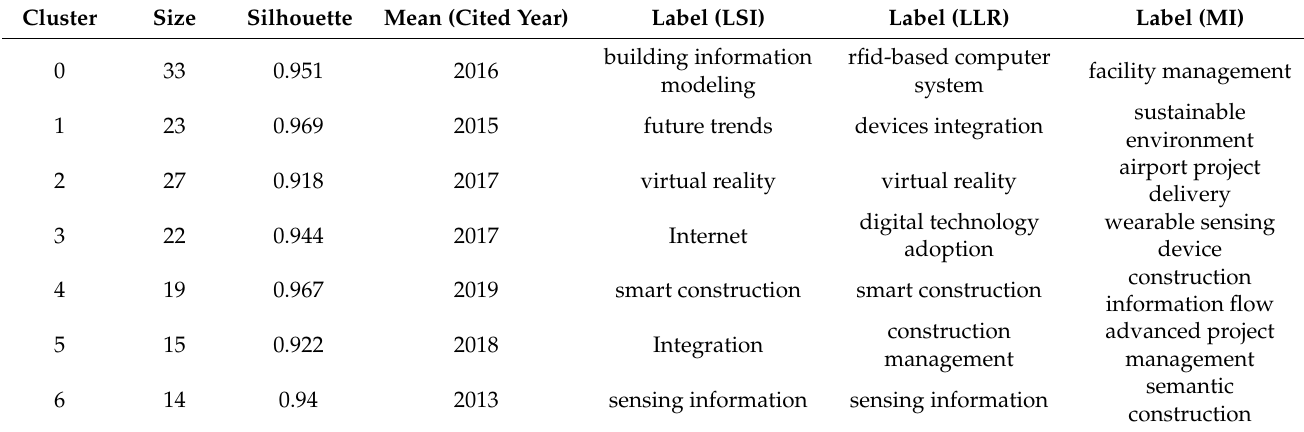
Figure 3. The network visualization on co-citation analysis of BIM–IoT integration literatures in the WoSc database via Citespace (generated by the authors). Table 1. Major clusters of co-cited literatures of BIM–IoT integration in the WoSc database via Citespace (generated by the authors).